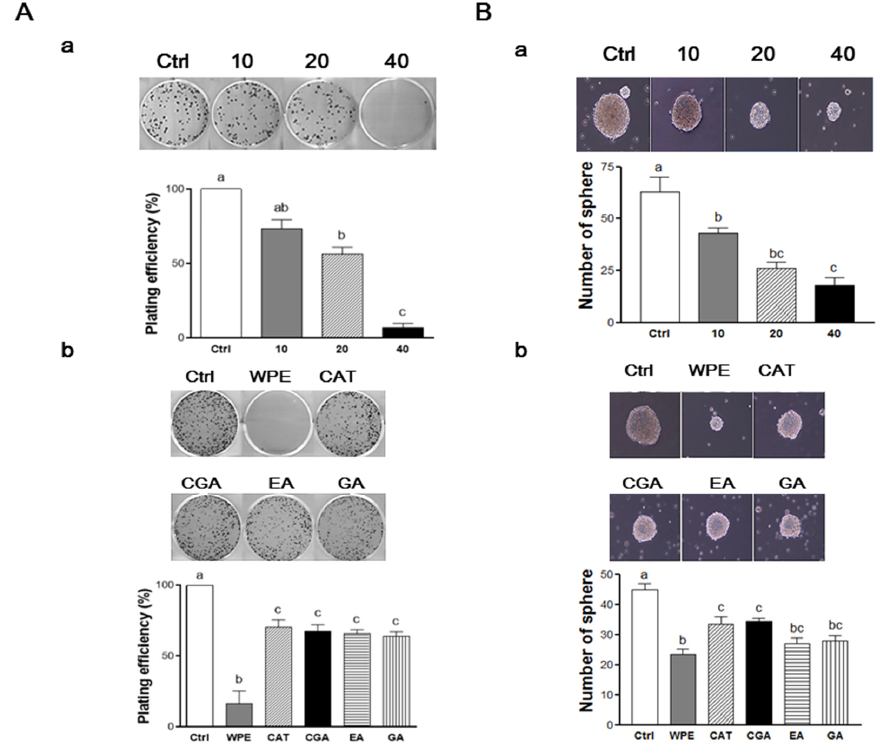
Figure 5. WPE and its bioactive compounds suppress self ‐ renewal capacity of colon CSCs. CD133 + CD44 + HCT116 cells were treated with varying concentrations of WPE (0, 10, 20, and 40 µ g/mL) ( Aa , Ba ); or concentrations of (+) ‐ catechin, chlorogenic acid, ellagic acid, and gallic acid comparable to 40 μ g/mL of WPE ( Ab , Bb ) for 6 days. Microscopy images of colony formation were obtained (magnification, 100×, upper panel) and the number of colonies were counted (lower panel). ( A ) Sphere images were obtained using phase contrast microscopy (magnification, 100×, upper panel) and sphere numbers were counted and quantified (lower panel) ( B ). The values shown are the means ± SEM. A p ‐ value < 0.05 was considered significant. Ctrl, Control; WPE, walnut phenolic extract; CSCs, cancer stem cells; CAT, (+) ‐ catechin; CGA, chlorogenic acid; EA, ellagic acid; GA, gallic acid. 3.6. WPE Down ‐ Regulates CD133, CD44, DLK1, and Notch1 in Human Primary Cells Obtained from CRC Tissue